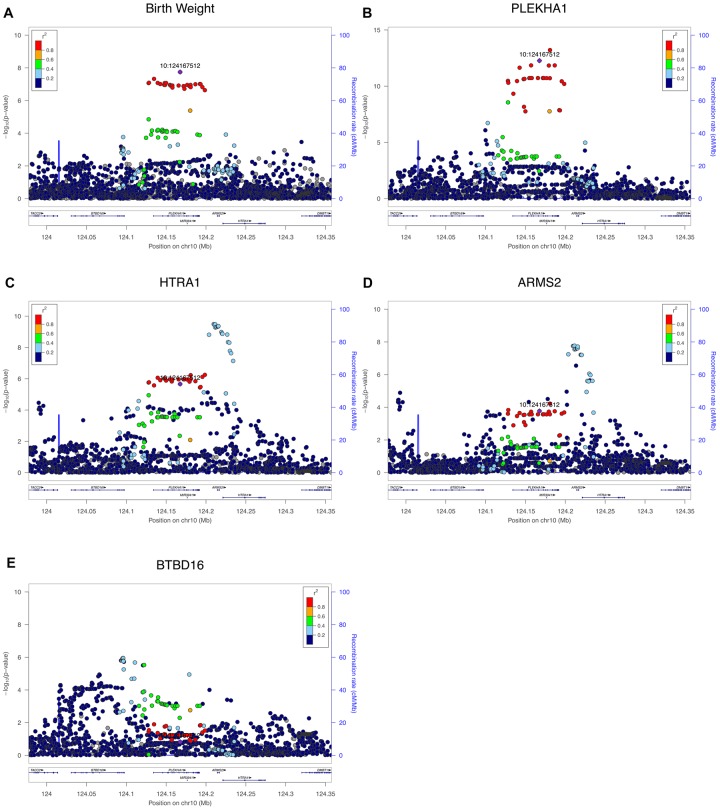
A, LocusZoom plots of BW GWAS peak with lead SNP rs2421016 (chr10:124167512). B, C, D, E, LocusZoom plots of eQTL peaks on PLEKHA1, HTRA1, ARMS2, BTBD16 genes, respectively.In these plots, each dot denotes a variant. Purple dots: lead SNP chr10:124167512; red and orange dots, SNPs of strong LD (r2>0.6) with lead SNP; green and light blue dots, SNPs of moderate LD (0.6>r2>0.2) with the lead SNP; and dark blue dots, SNPs of weak or no LD (r2<0.2) with the lead SNP.